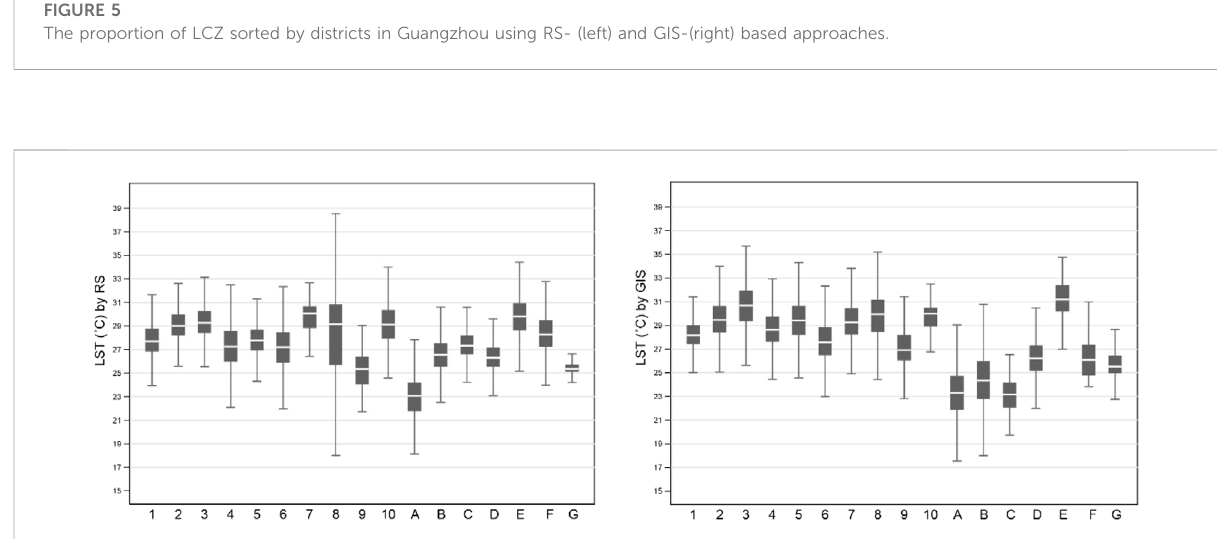
FIGURE 6 BoxgraphsforaverageLSTsextractedinLCZsclassi fi edbyRS(left)andGIS(right):thewhitelineintheboxshowsthemedian;thebottomlineof the grey box indicates the fi rst quartile; and the top line indicates the third